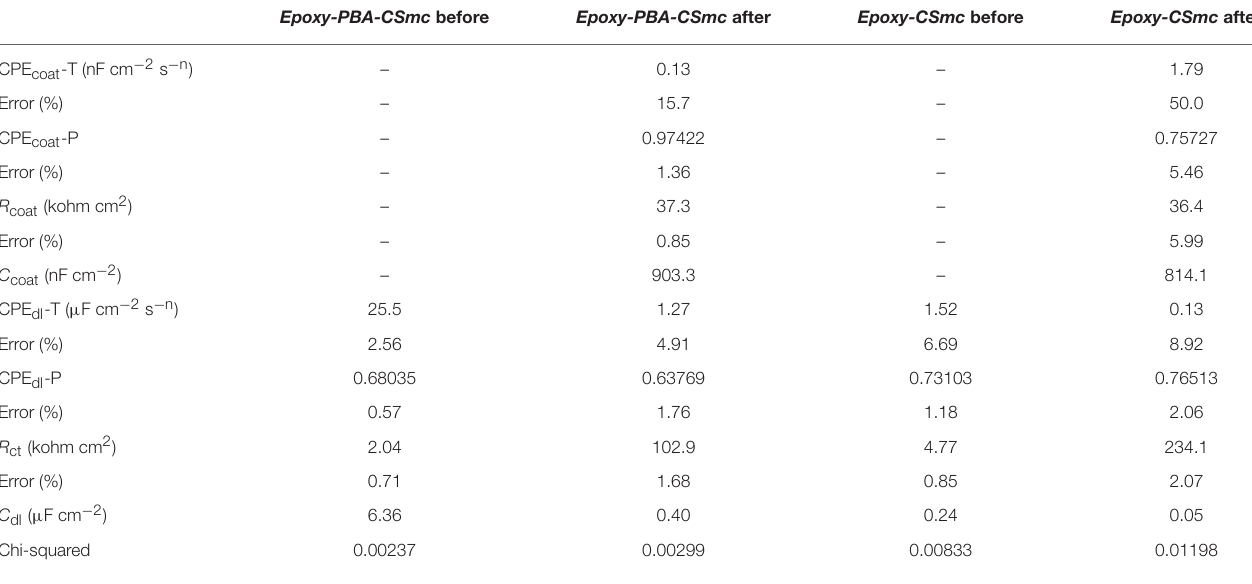
TABLE 3 | Fitting parameters according to equivalent circuits of Figures 7A,B of the scribed Epoxy-PBA-CSmc and Epoxy-CSmc coatings after their exposure for 1h into 5mM NaCl, before and after heat-induced